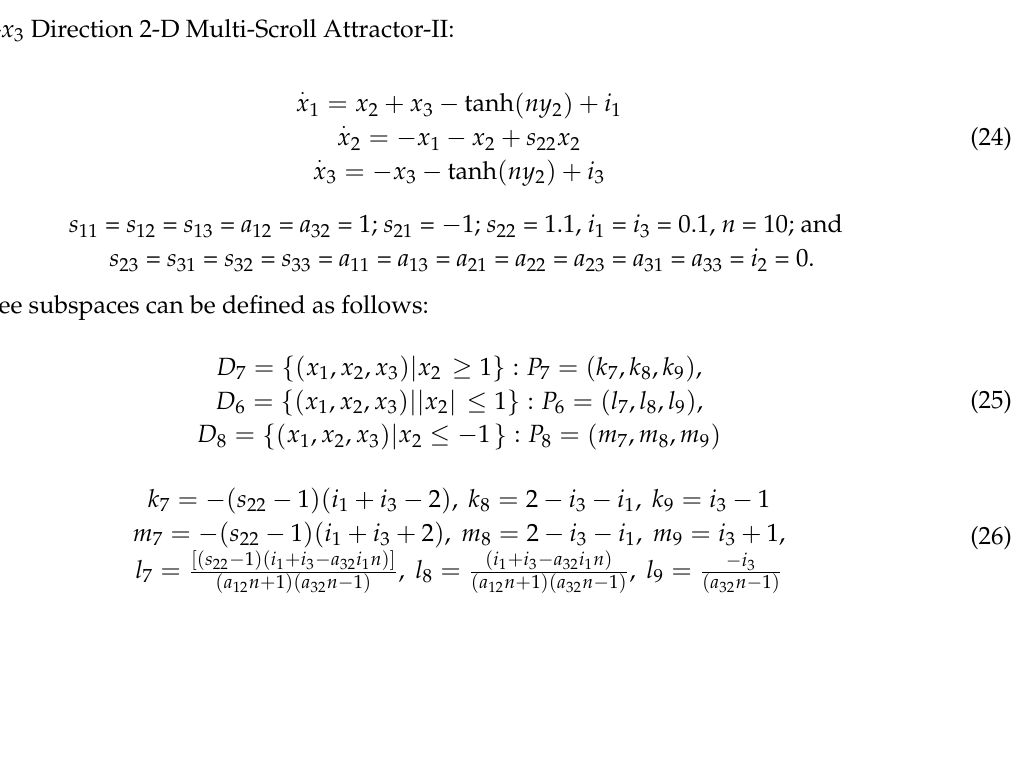
Figure 6. Numerical results of the x 1 - x 3 direction2-D multi-scroll SC-CNN based system-I: ( a ) 2-double scrollin x 1 - x 2 - x 3 plane; ( b ) variable x 1 (t); ( c ) 12-double scrollin x 1 - x 3 plane; and ( d ) variable x 1 (t).